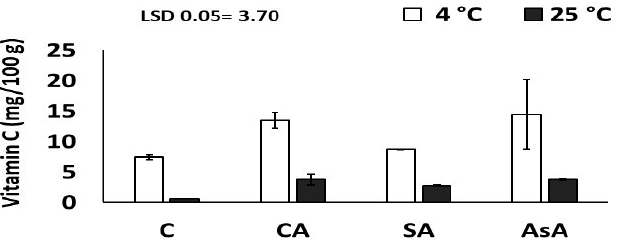
Figure 10. Effects of bio-stimulants B, control (C), citric acid (CA), salicylic acid (SA) and ascorbic acid ( AsA) and storage temperature T (4 °C and 25 °C) vitamin C content of okra pods stored for 12 days. Error bars are the ±SD of the means of three biological replicates. LSD values ( p ≤ 0.05) for B = 2.6 and T = 1.9. LSD for B × T is presented on the figure.